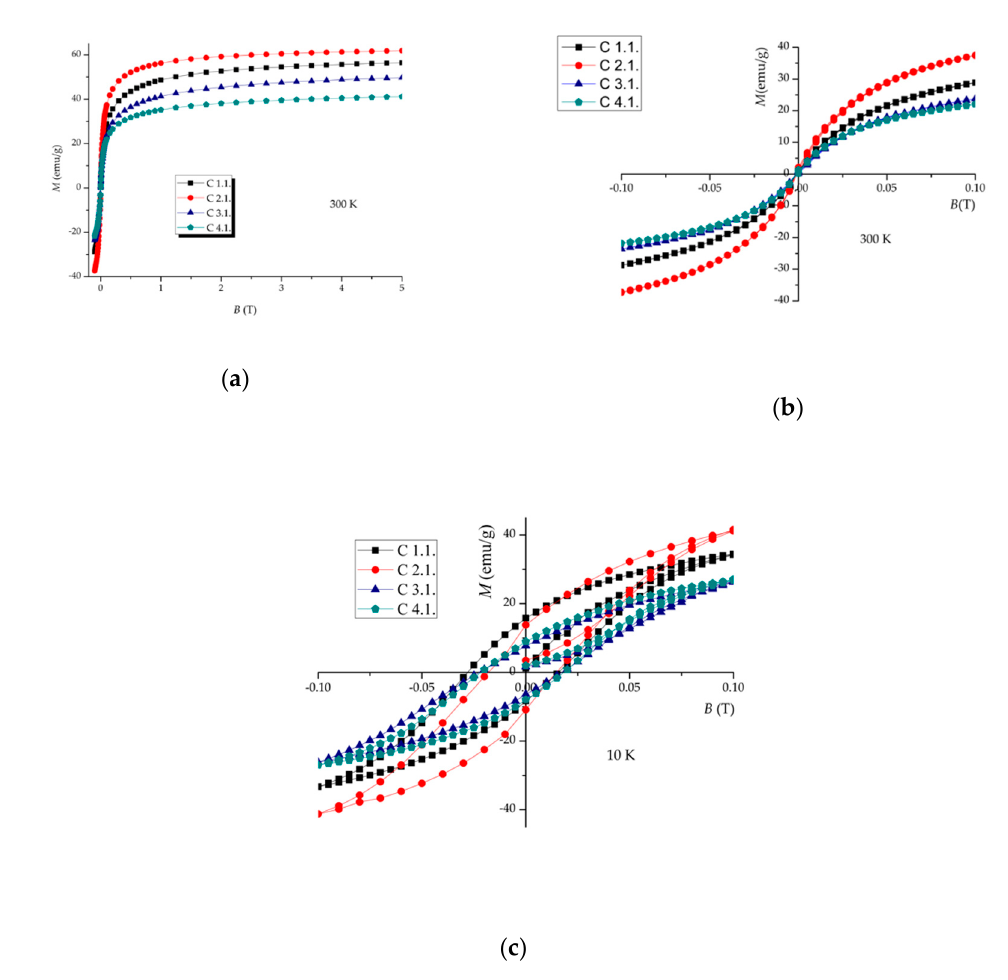
Figure 9. Field dependence of magnetization at 300 K for the naked SPIONs (samples C): ( a ) magnetization curve up to 5 T at 300 K, ( b ) hysteresis cycle at 300 K, ( c ) hysteresis cycle at 10 K.